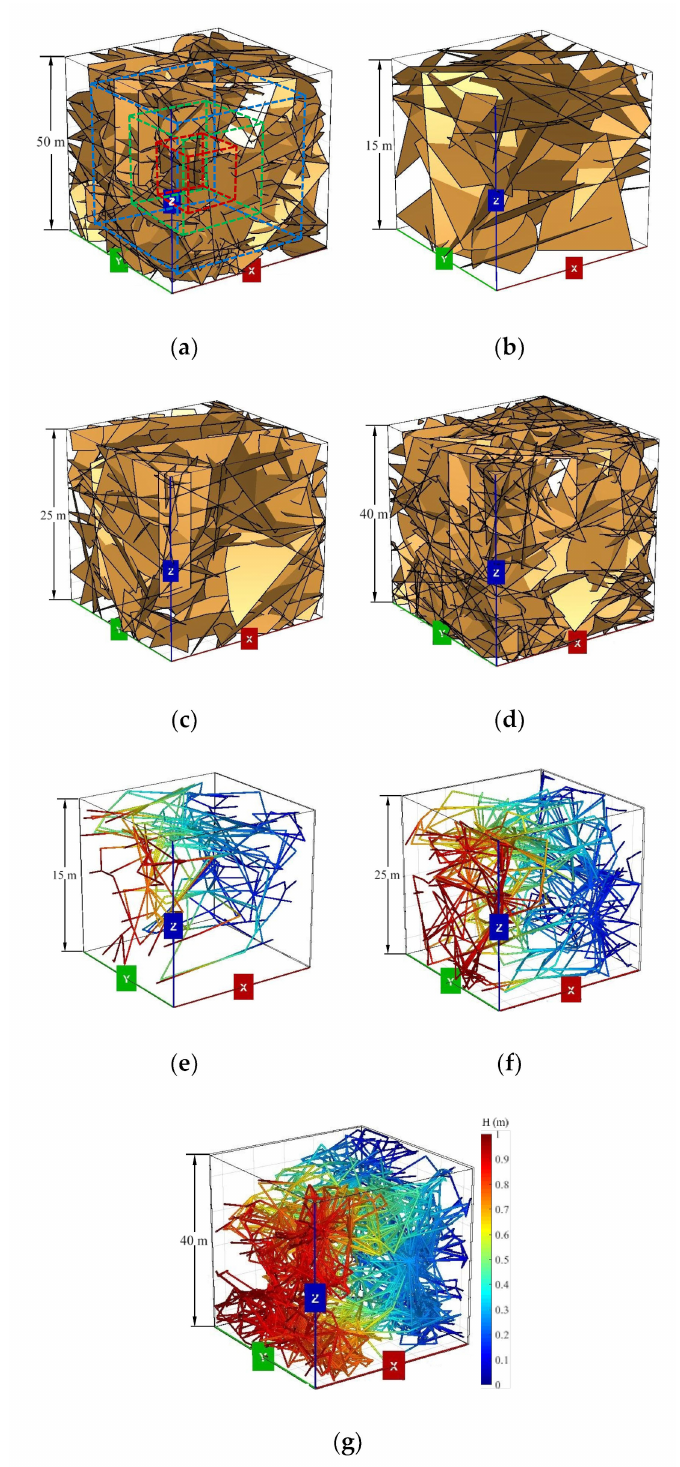
Figure 11. Extracted sub-models from the original cube DFN model. ( a ) Original cube DFN model ( L n = 50 m); ( b ) Sub-model ( L n = 15 m); ( c ) Sub-model ( L n = 25 m); ( d ) Sub-model ( L n = 40 m); ( e ) EPN model ( L n = 15 m); ( f ) EPN model ( L n = 25 m); ( g ) EPN model ( L n = 40